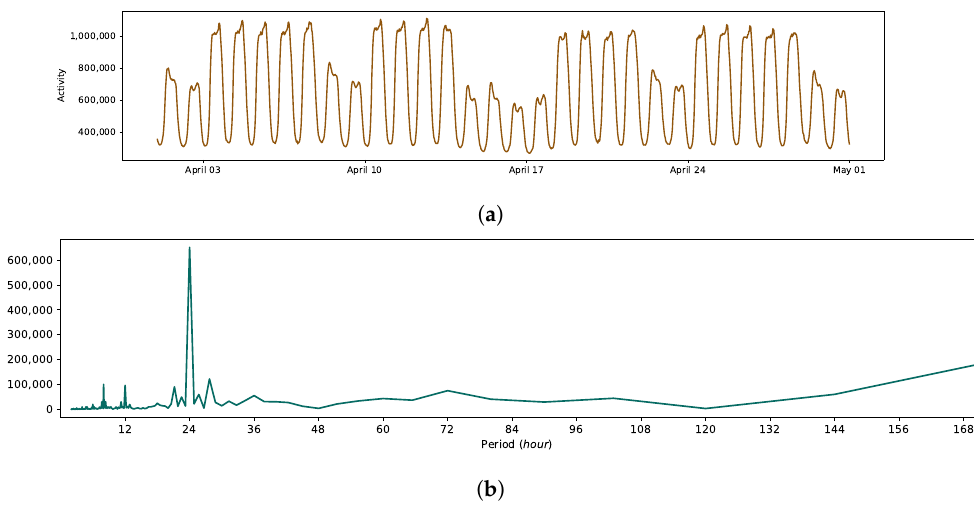
Figure 5. The mobile phone network activity ( a ) during the observation period of April 2017, and its Fourier decomposition ( b